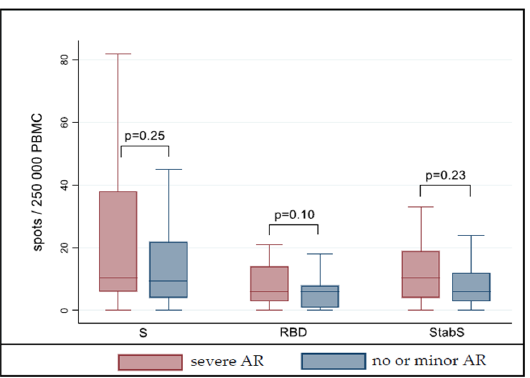
Figure 1. Antibody response and neutralization activity according to reactogenicity after second vaccination with BNT162b2. Shown are boxplots of RBD-specific SARS-CoV-2-IgG endpoint titers (Panel ( A )) and half maximal inhibitory concentrations (IC 50 ) in a pseudovirus neutralization assay (Panel ( B ), one outlier not included, leftmost bar IC 50 4231), separately in men and women. Dots indicate outliers. AR = adverse reaction(s). Severe AR = any adverse reaction(s) after first and/or second vaccination resulting in sick leave; no or minor AR = no or only minor injection side symptoms after first and second vaccination.